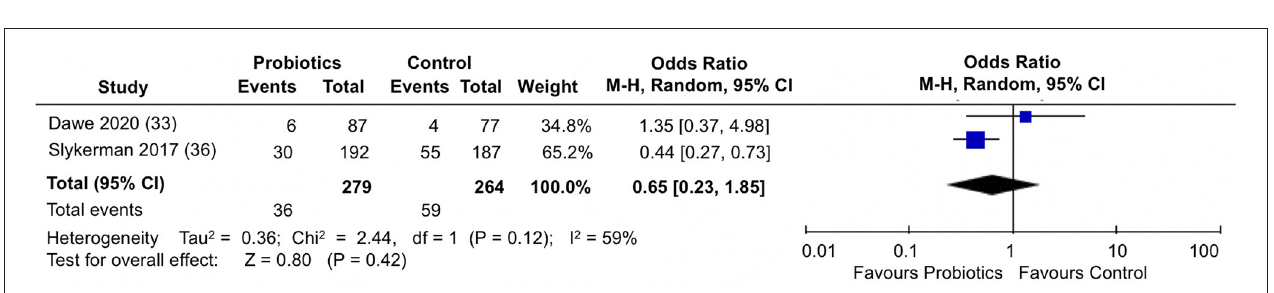
( Figure 7 ), the pooled estimate from the two trials (33, 36) showed no differences between probiotics and control groups (pooled OR: 0.65; 95% 0.23, 1.85; I 2 = 59%).